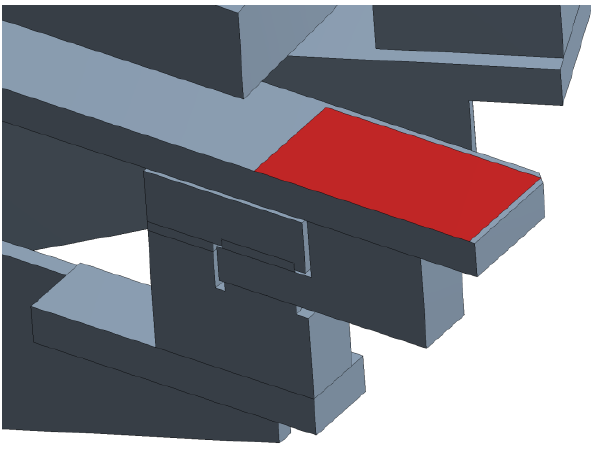
Figure 16. Target surface for the application of remote forces.